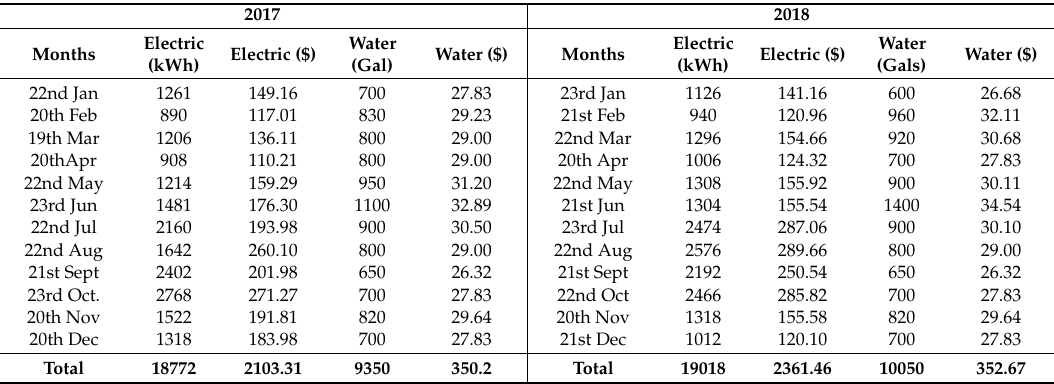
Table 3. Summary of Utility Bills for 2017 and